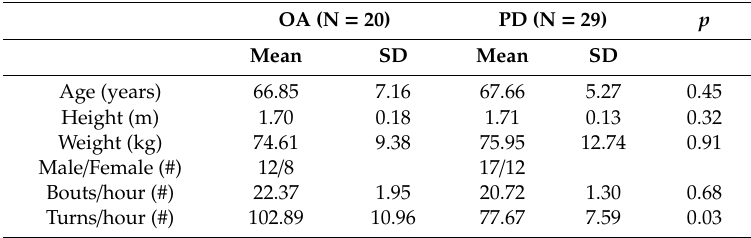
Table 1. Demographics and activity characteristics of each